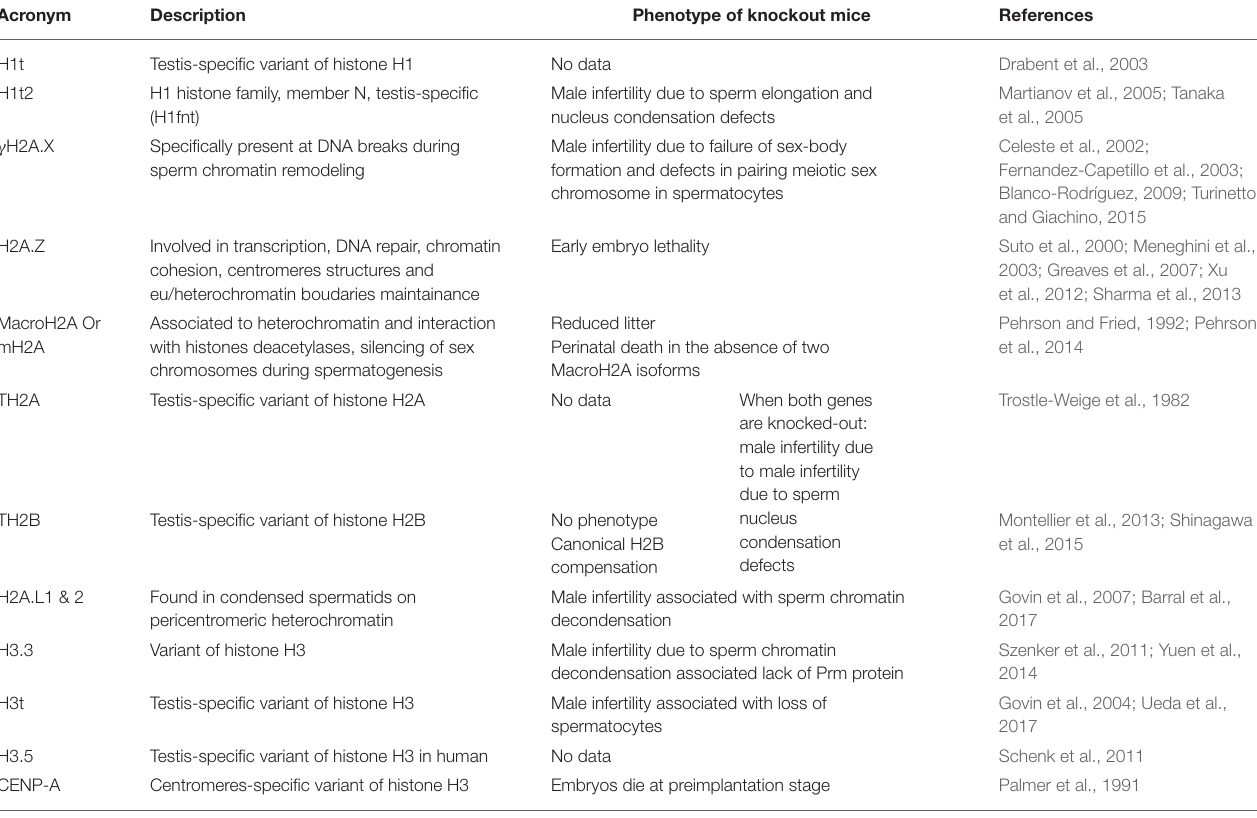
TABLE 1 | Variant histones in mammalian sperm